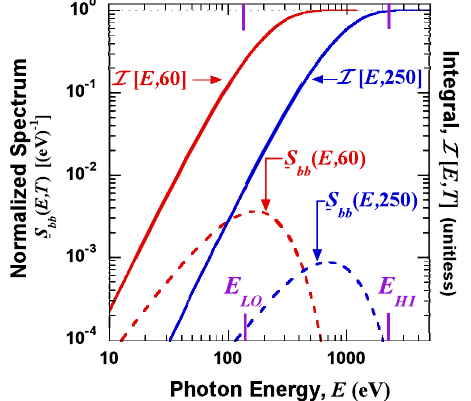
FIG. 5. Normalized spectral shapes and cumulative shape in- tegrals for Planckian spectra of temperatures T ¼ 60 eV and 250 eV. The dashed curves (left axis) are normalized Planckian ð E; T Þ . The solid curves [right axis] show the shape functions, S R bb E ð E 0 ; T Þ dE 0 S corresponding cumulative integrals, I ½ E; T (cid:7) ¼ bb 0 ; T (cid:7) (cid:8) 1 . The unfold interval, for E (cid:2) E , where I ½ E MAX MAX (cid:7) ¼ ½ 137 eV ; 2300 eV (cid:7) is indicated. (Both or- ½ (cid:1) E (cid:7) ¼ ½ E ; E LO HI dinate axes share the same numerical scale, but different